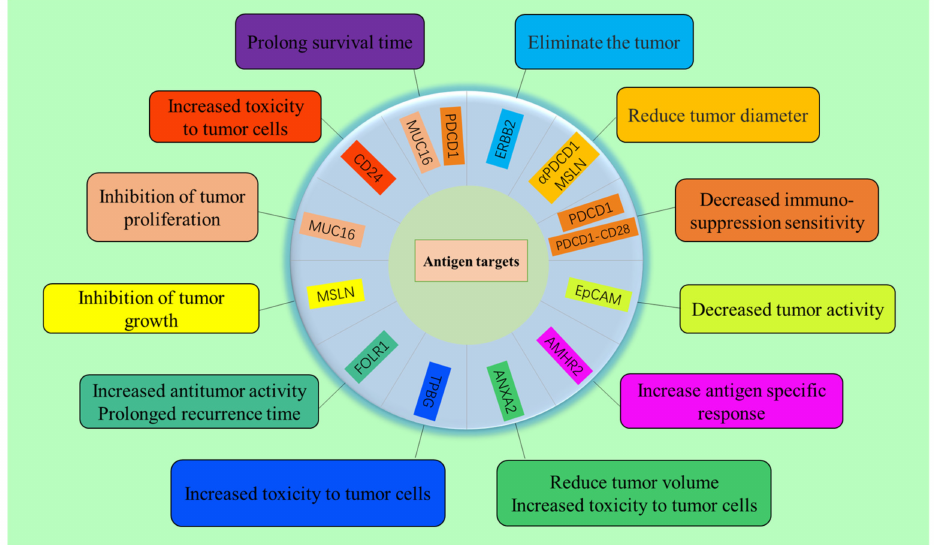
Figure 2. Antigenic targets of OC cells and related functions of CAR-T cells targeting these tumor